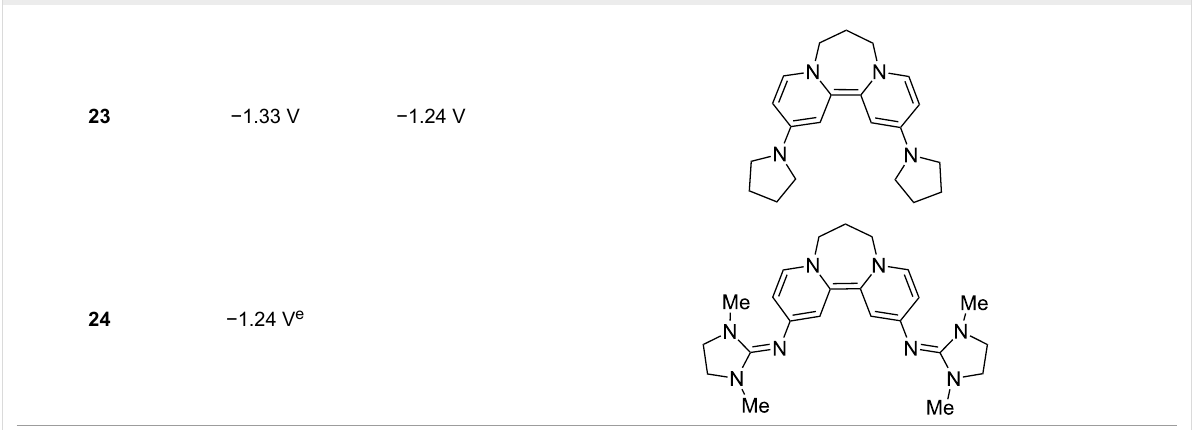
Table 1: Oxidation potentials of organic electron donors a